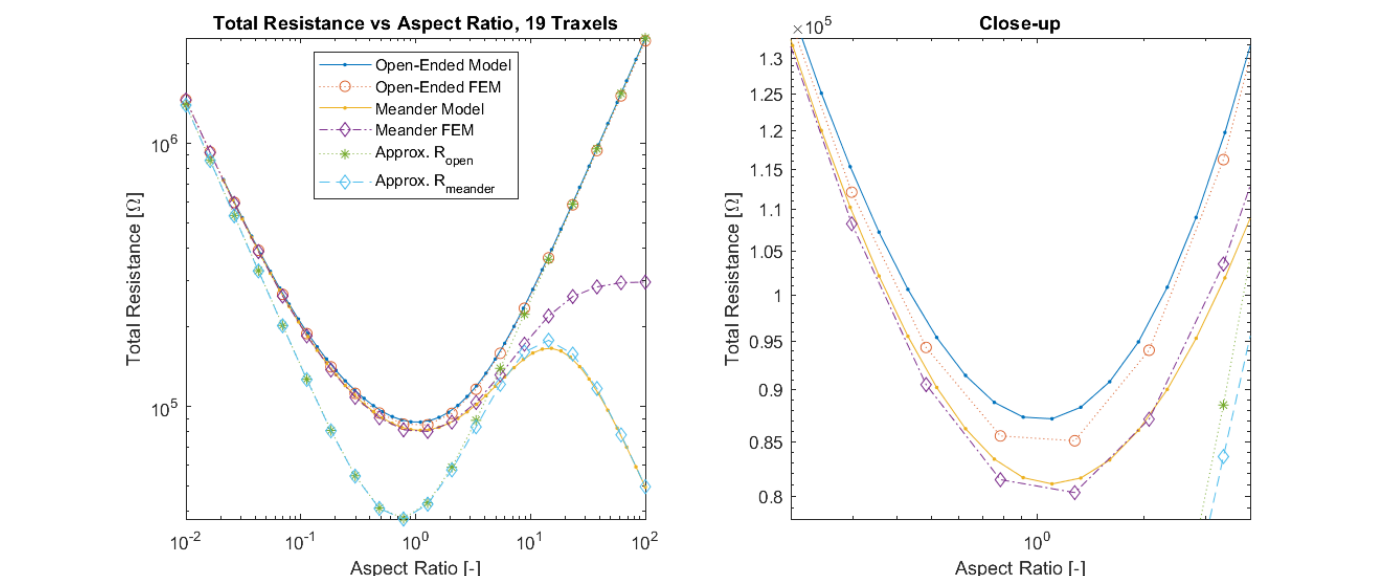
Figure 14. A comparison of the total resistance as function of aspect ratio for open-ended and meandering traxels between the model, FEM simulation, and resistance approximation results. Errors between model and FEM results occur at an aspect ratio around 1 due to 2D-conduction effects and for the meandering case for large aspect ratios due to the increased importance of the resistance of the meandering